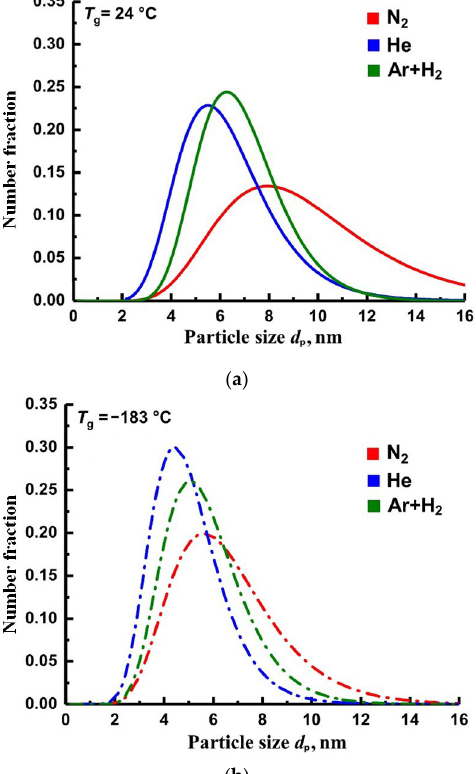
Figure 5. Size distribution of primary Au nanoparticles at temperatures 24 °C ( a ) and –183 °C ( b ) for various type of gases N 2 , He, and Ar + H 2.